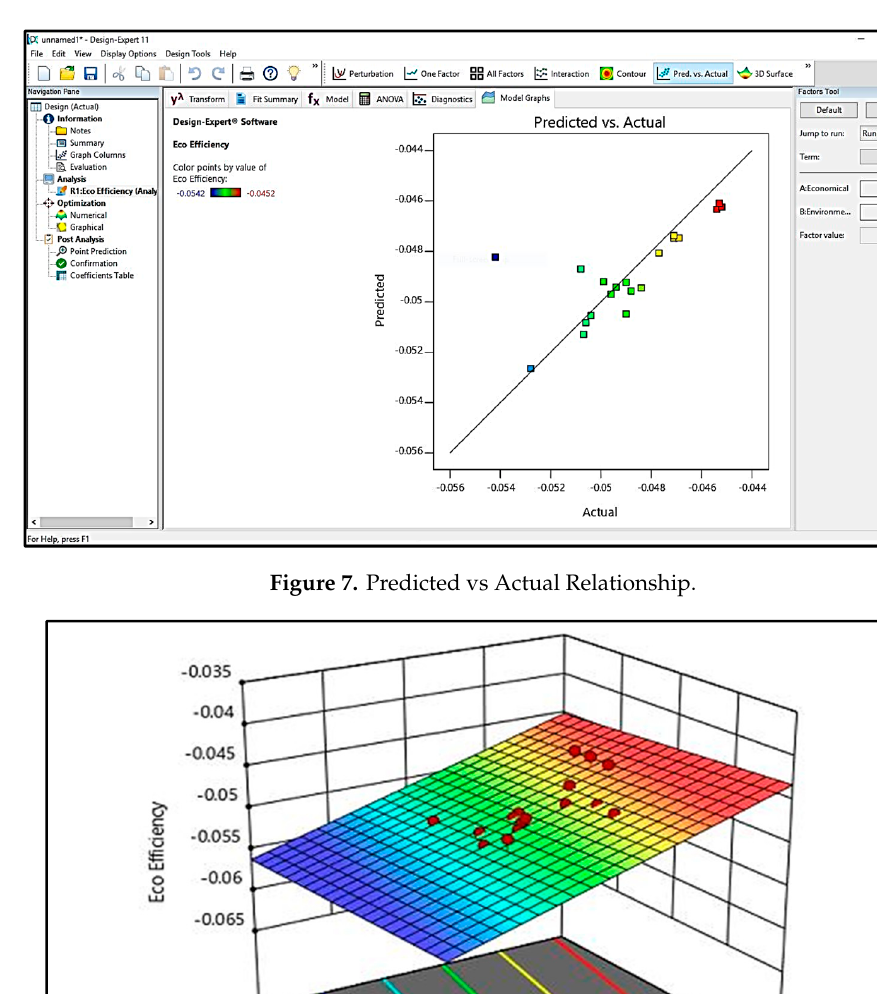
Figure 8. Surface Model Graph